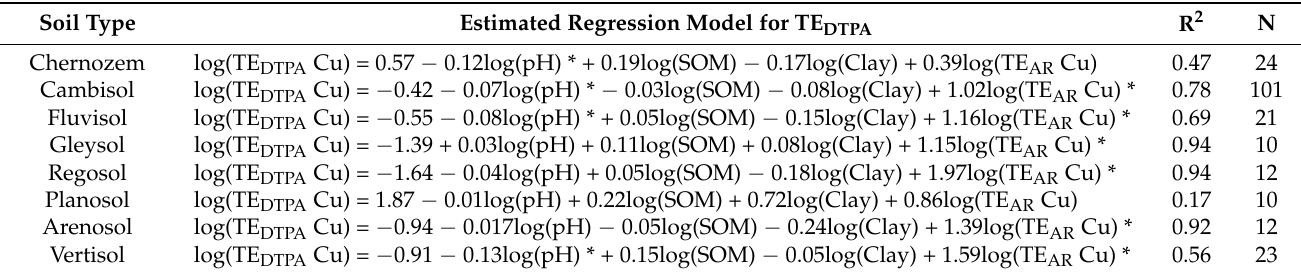
Table 14. Prediction model